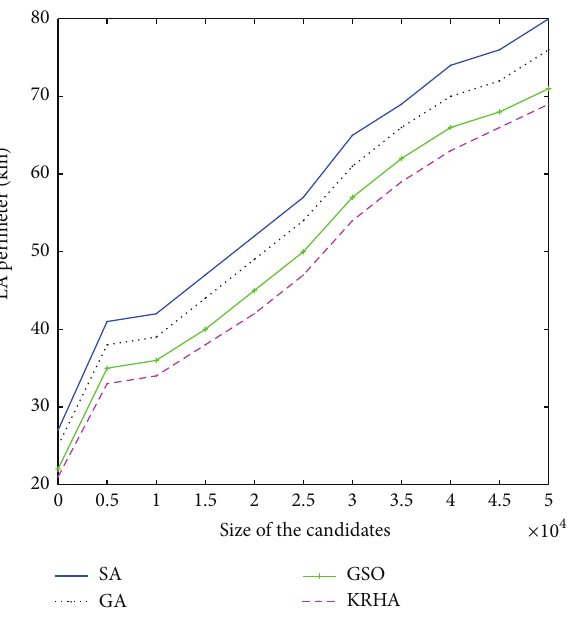
Figure 5: Variation of perimeter of location area for change in candidate size.